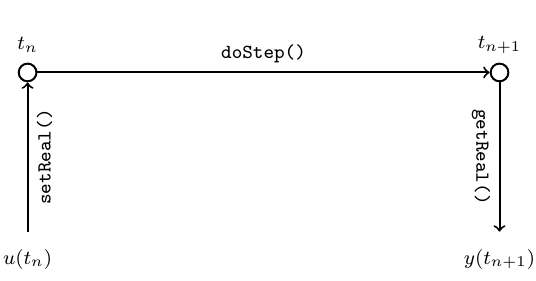
Figure 2: With FMI for co-simulation, input variables can only be provided at the beginning of each step.